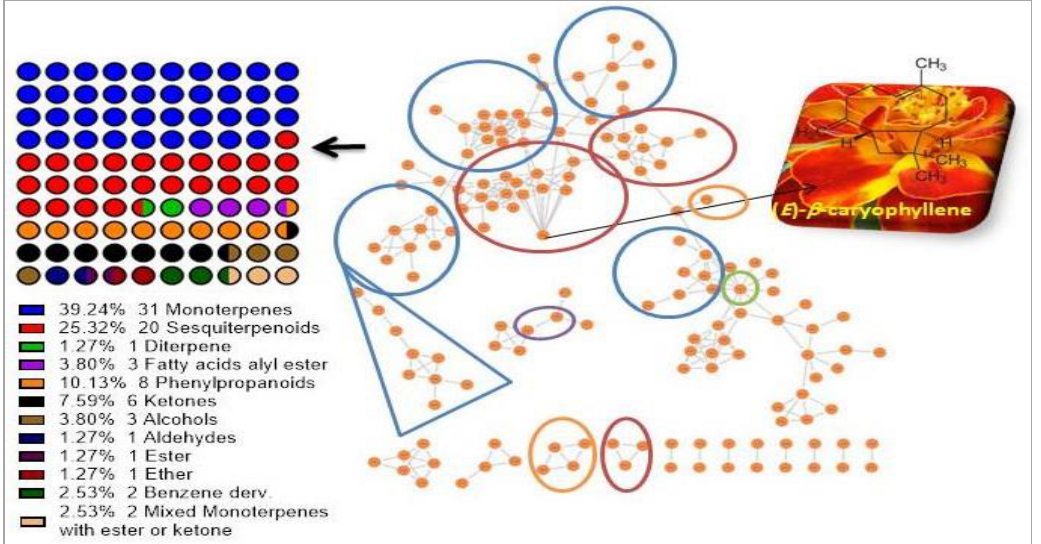
Figure 3. Molecular network of the GC/MS analysis of the identified volatile constituents from T. patula , and the percent of metabolites classes. All nodes are labeled with the retention time from the GNPS-GC/MS spectral libraries.